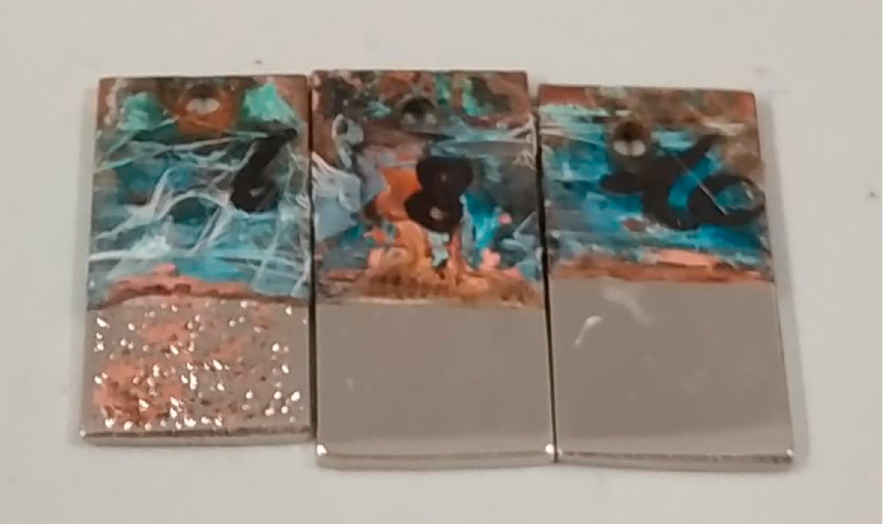
Figure 5. Palladium chemical plating samples after 7 days of aging. Sample number is reported on the uncoated part of each sample (from left to right, samples #6C, #8C, #10C). The deposits obtained were analysed using XRF [49,50], the total palladium film thicknesses obtained summing PDP+PCP processes are shown in Table 5. The average values and the standard deviations were the result of three measurements carried out in different spots that were randomly chosen. Table 5. XRF thickness determination of palladium coatings. The thicknesses of the palladium coatings derived from PDP+PCP procedure are reported in the second column.